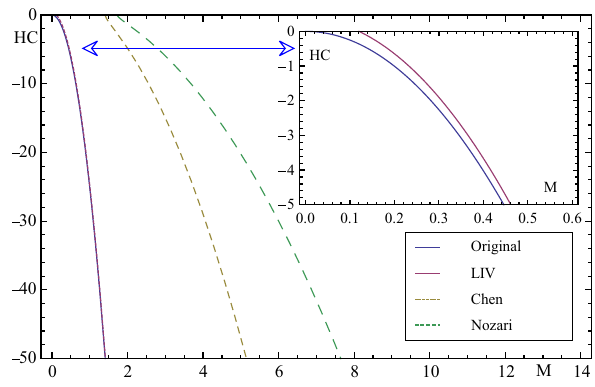
Fig. 5 The black hole’s modified heat capacity versus its mass when employing the GUP parameters β 0 = α = 1 and the LIV parameter ξ = 1 2